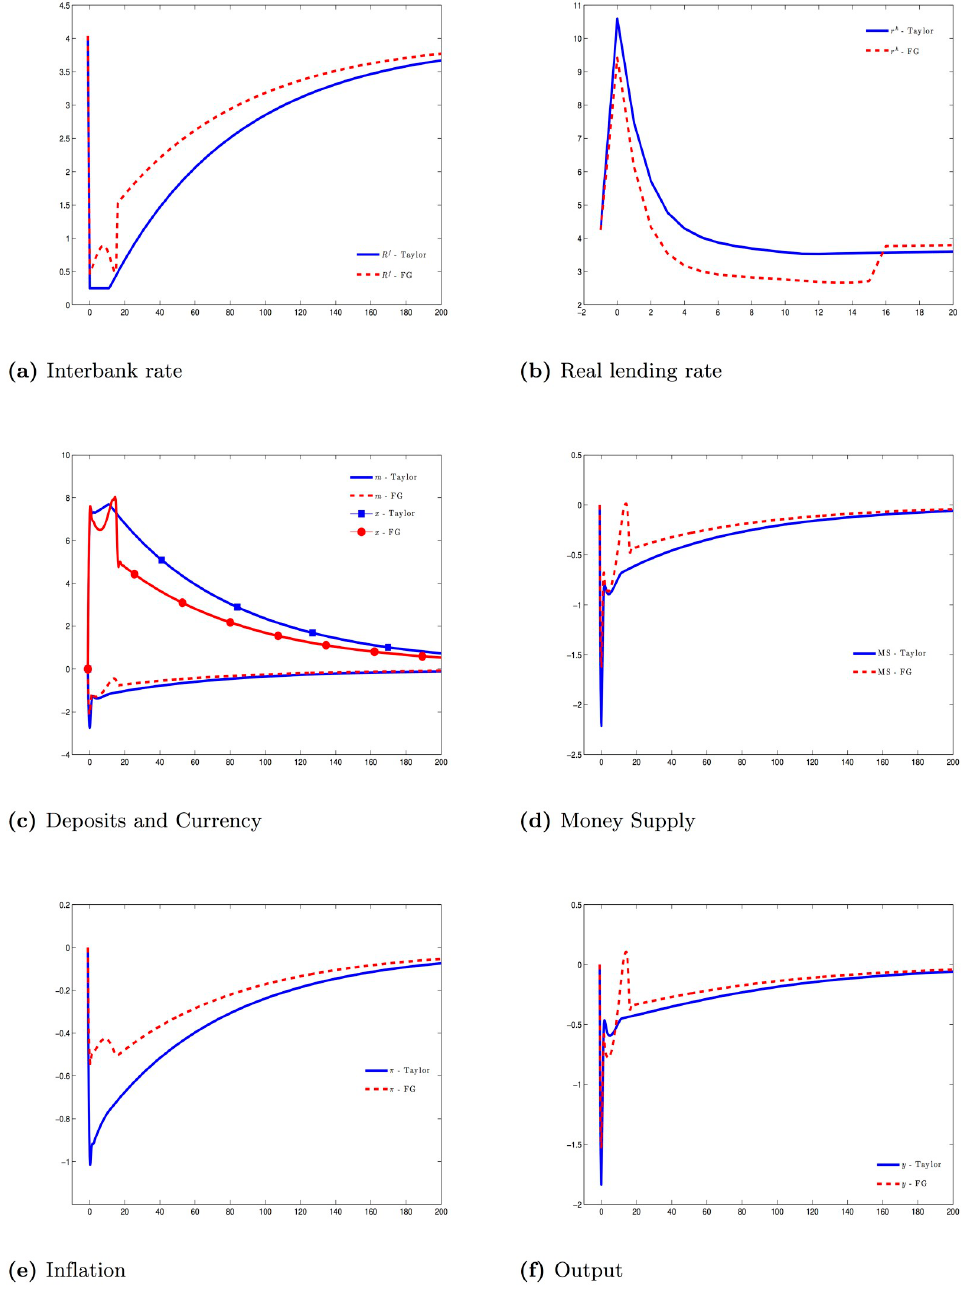
Fig 3. Financial crisis—Forward guidance (FG- M4) and Taylor rule (Taylor-